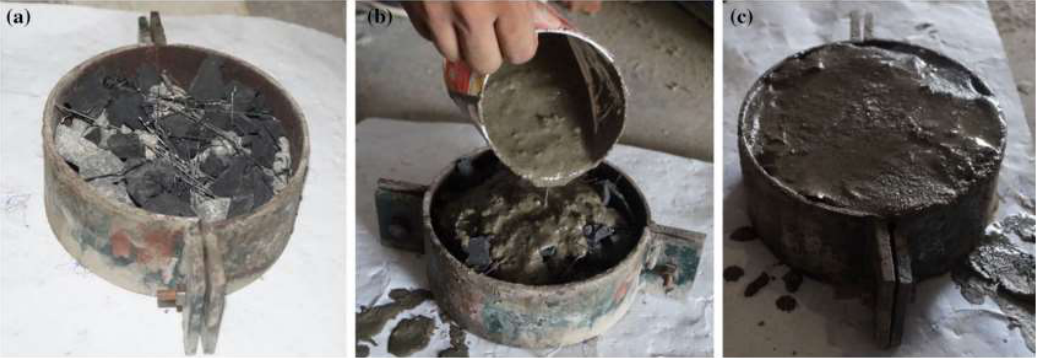
Figure 23. Preparation process of rubber concrete. ( a ) Arrange coarse aggregate, rubber and steel fibers. ( b ) Gravity method. ( c ) Sample [71].